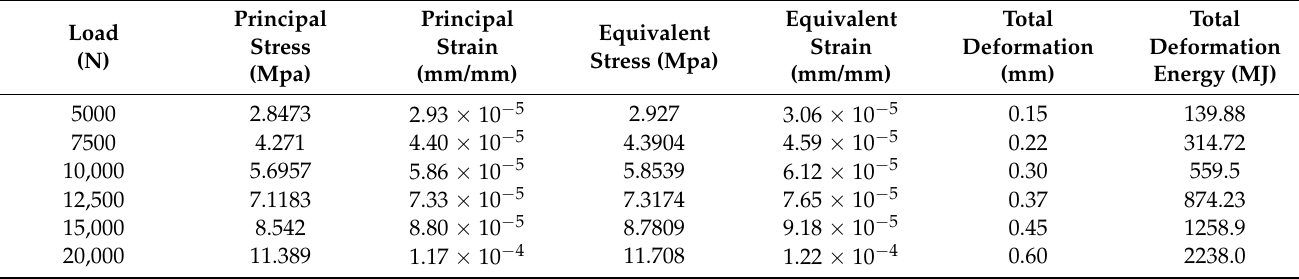
Table A3. Strain and stress isostatic parameters of the benthic